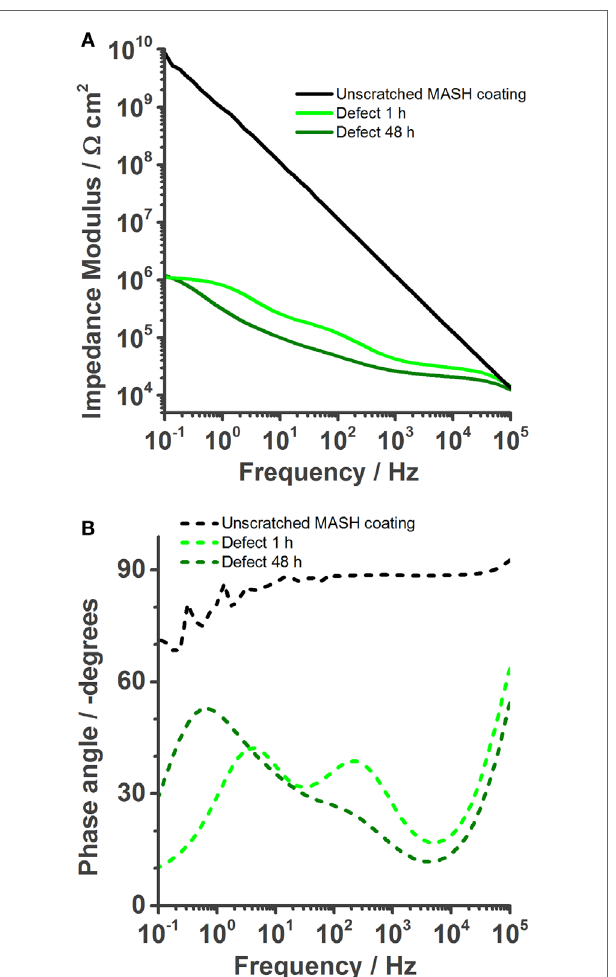
FigUre 6 | Bode plots of the Mash coating immersed in 0.05 M nacl solution . The undamaged coating shows even better barrier properties than the barrier properties of self-healing reference coating. (a) Once a defect is inflicted into the coating, its impedance is naturally also reduced (1 h). However, over time (48 h) the impedance modulus stays more or less constant. The phase plot (B) shows the reduction of the coating capacitance, but an increase of the phase angle at low frequencies, a result of the protection